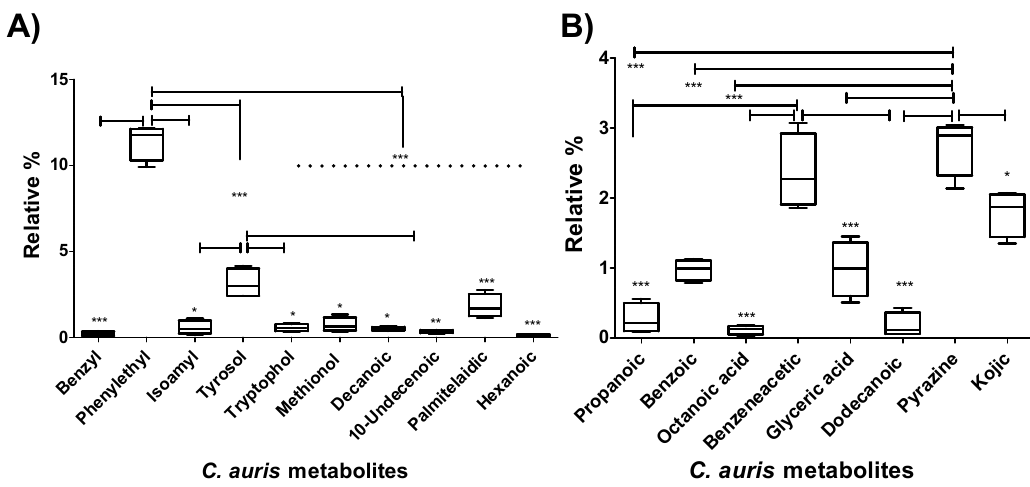
Figure 4. Relative percentages of metabolites produced by C. auris CAU09 cultures. ( A ) The metabolites produced by the organism for the purpose of its morphogenic changes. ( B ) The metabolites produced by the organism for the purpose of protection and colonization. The quantity of each metabolite was represented as the relative percentage by measuring the area under the peak of each metabolite in relation to the total areas of all other metabolites detected in the extract. The data display the mean of the relative percentage ± standard error of the mean. The data was graphed using Box-and-Whiskers Plots and analyzed by one-way analysis of variance (ANOVA) using Bonferroni’s Multiple Comparison Test. P value < 0.05 was considered as significant. The standard error represents the mean of 4 replicas of two independent experiments. The level of significance was indicated by asterisks.